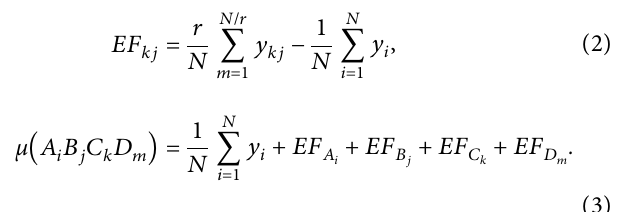
Table 2: Scheme of L